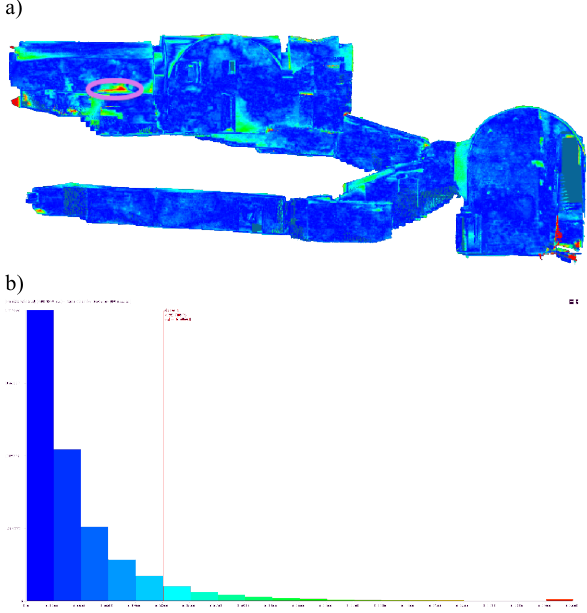
Figure 5. a) Result of the comparison faces / cloud; b) 92% of distances below 5 cm.